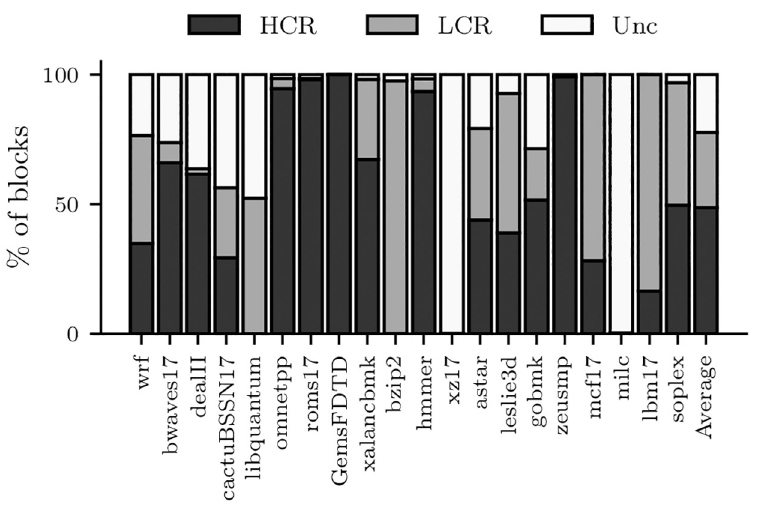
Fig 3. Block classification regarding its compression ratio for the selected SPEC CPU 2006 and 2017 applications.